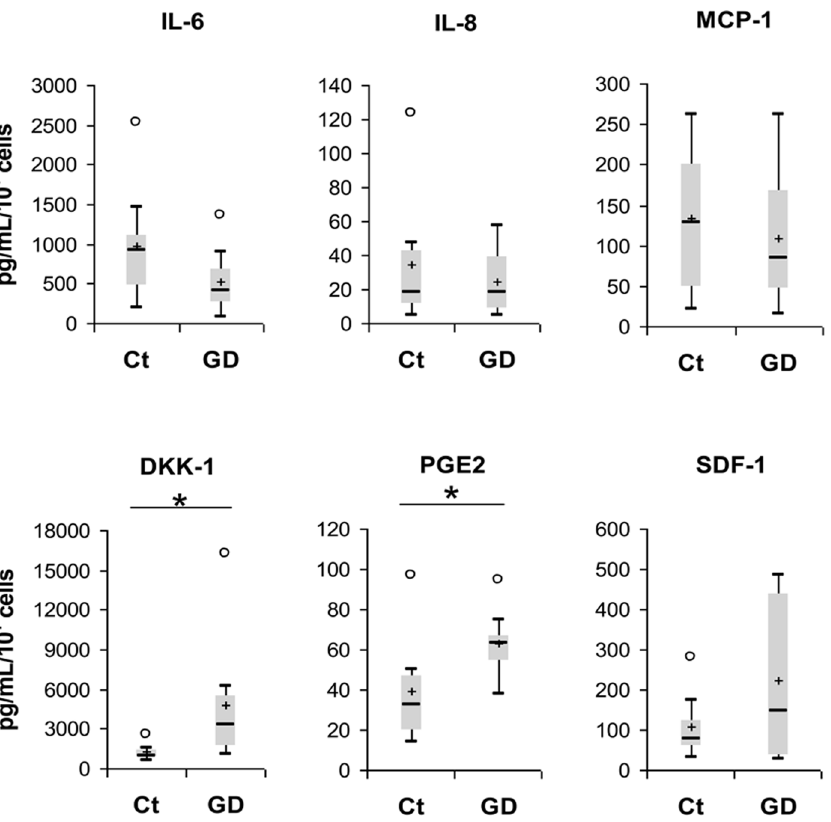
Figure 5. MSCs ’ soluble factors secretion. Interleukin-6 (IL-6), IL-8, Monocytes chemotactic protein-1 (MCP-1), Dickkopf-related protein-1 (DKK-1), prostaglandin-E2 (PGE2), and stromal cell-derived factor-1 (SDF-1) levels were measured in supernatants obtained from controls and GD-MSCs (n=8). Levels were normalized to the number of cells.